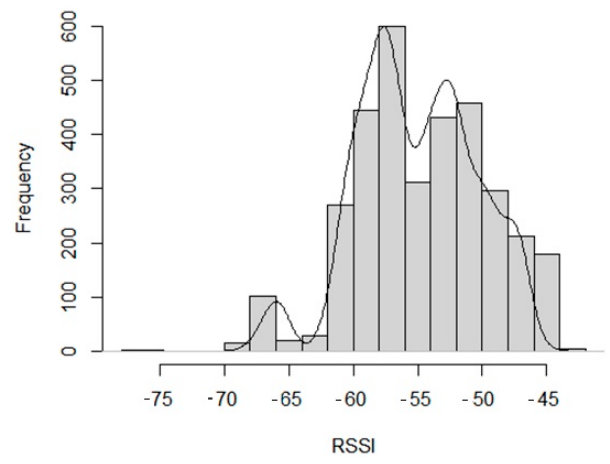
Figure 5. Samples of RSSI distribution over three minutes (3 ft, Stand).